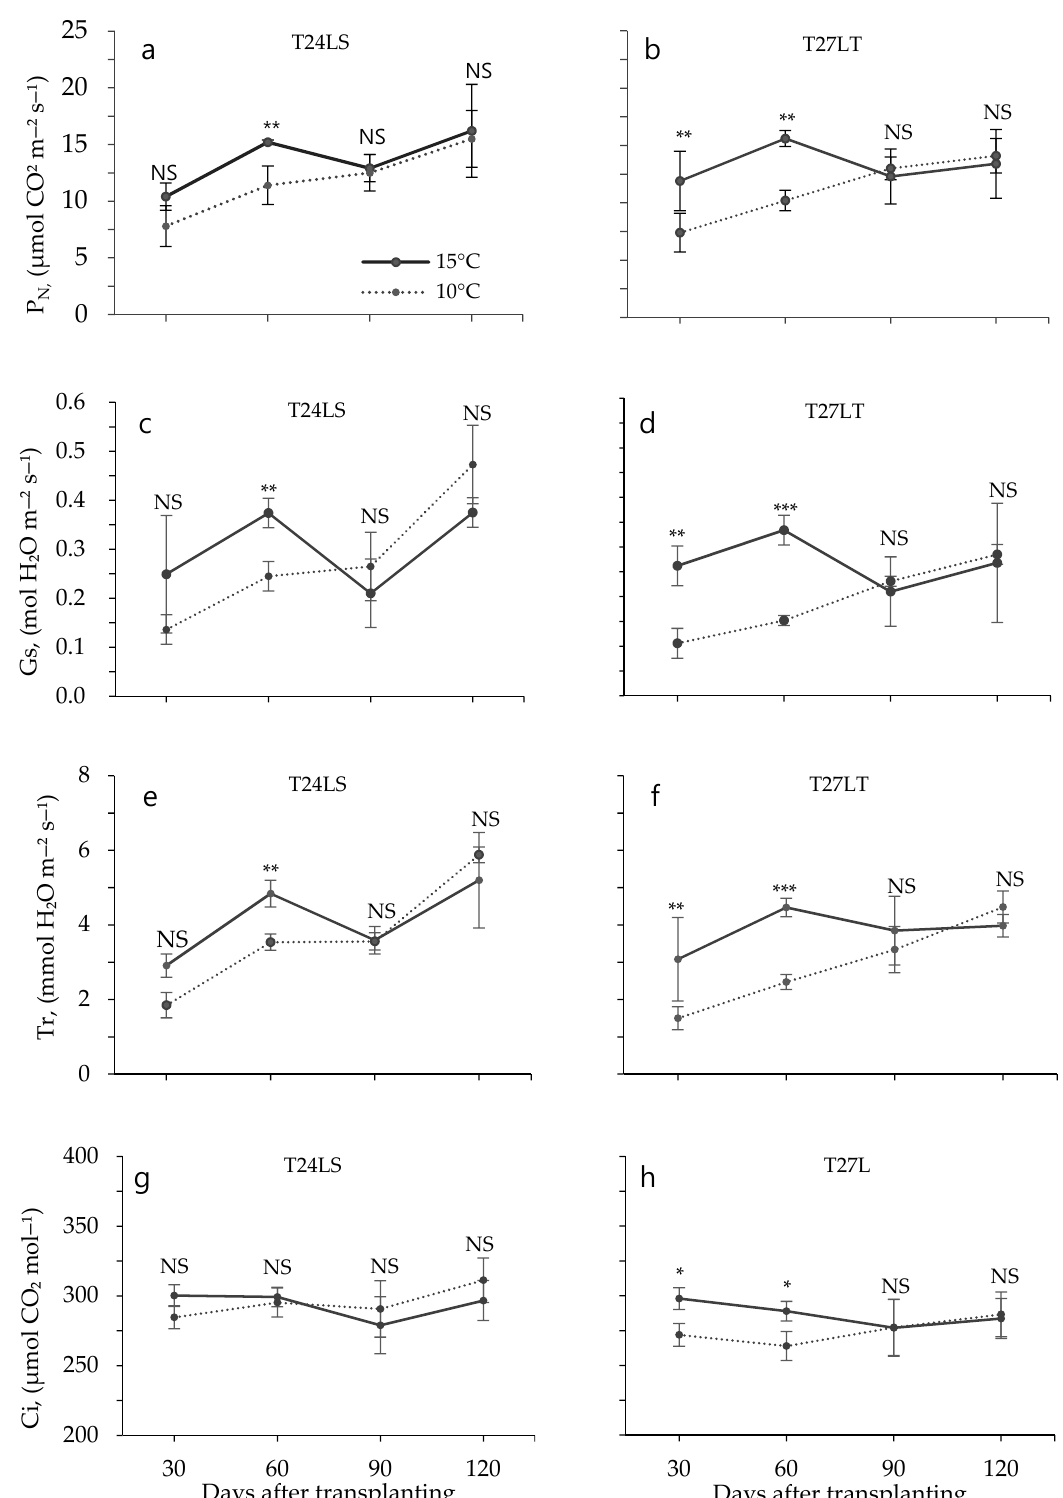
Figure 3. Changes in photosynthetic parameters of large-fruit-type accessions sensitive or tolerant to low night temperature grown in 10 and 15 °C. P N —photosynthesis rate ( a , b ), Gs—stomatal conductance ( c , d ), Tr—transpiration rate ( e , f ) and Ci—intercellular CO 2 concentration ( g , h ) were presented for sensitive and tolerant accessions, respectively. LS: large sensitive and LT: large tolerant. Values are means ± SD (n = 3). NS, *, ** and *** indicate not significant and significant at the p ≤ 0.05, p ≤ 0.01 and p ≤ 0.001 levels in t -test, respectively.